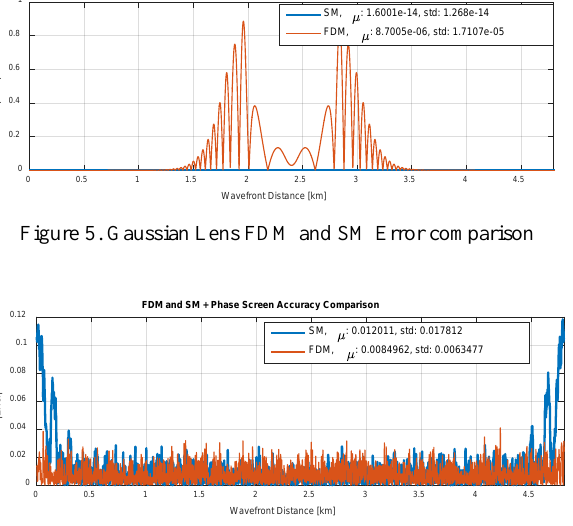
FDM, : 8.7005e-06, std: 1.7107e-05